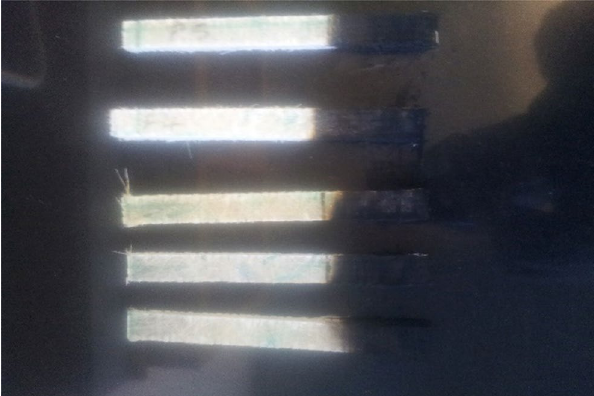
Figure 8. Remains of the samples after the burning